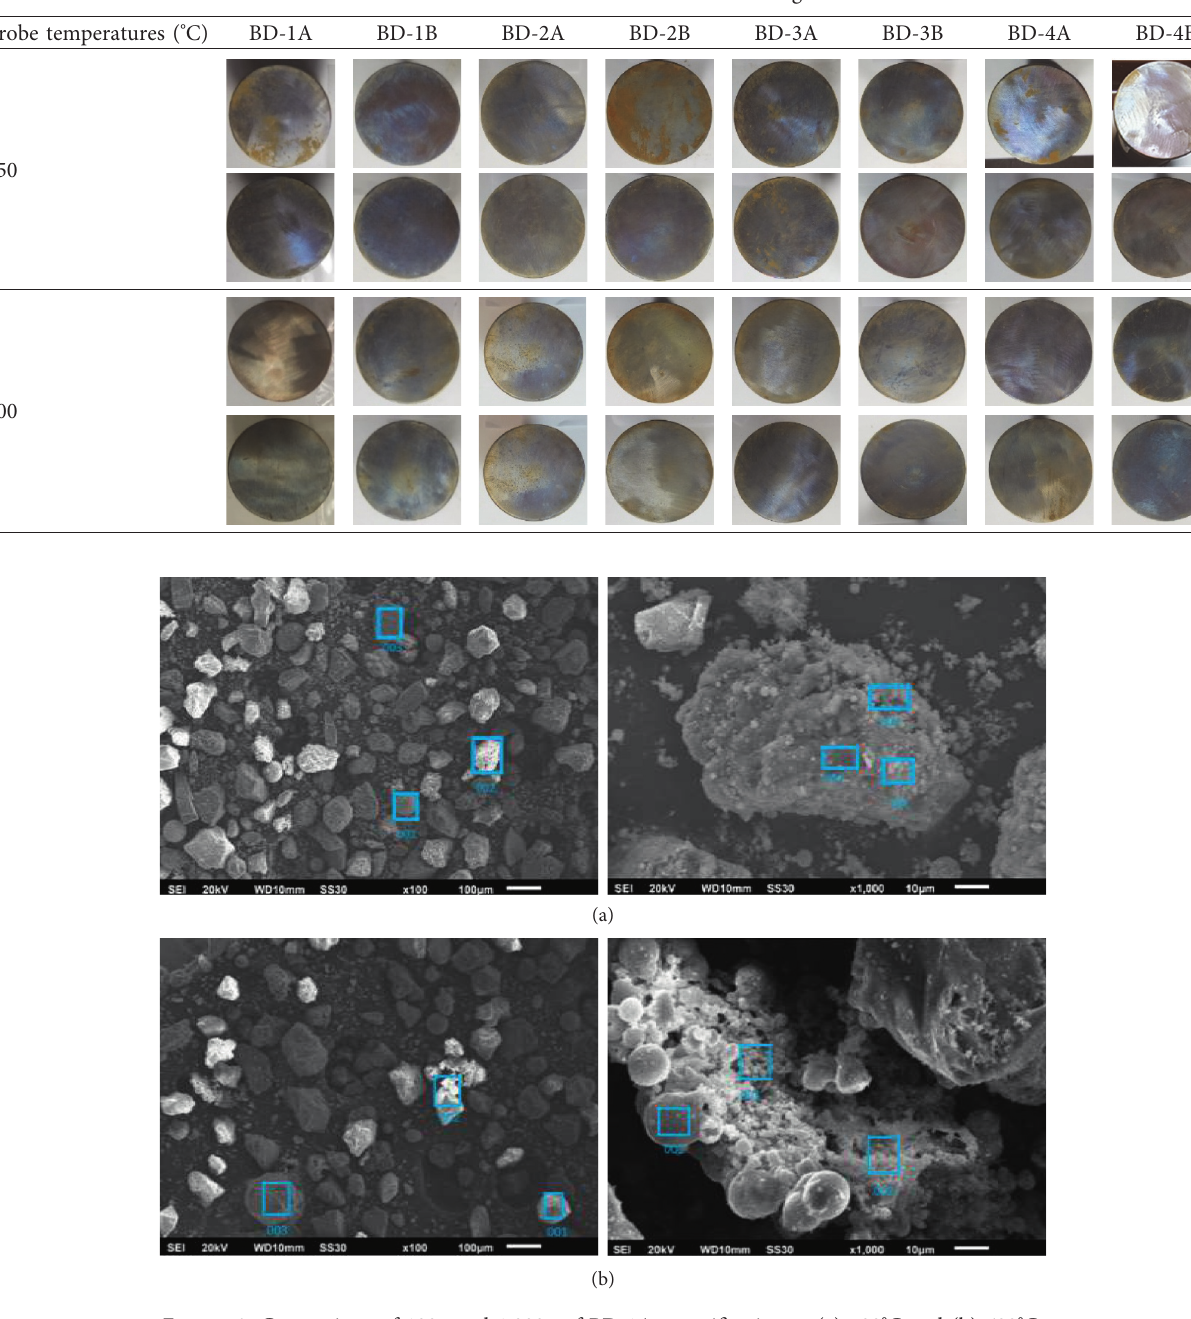
Table 5: Probe condition after ash cleaning.